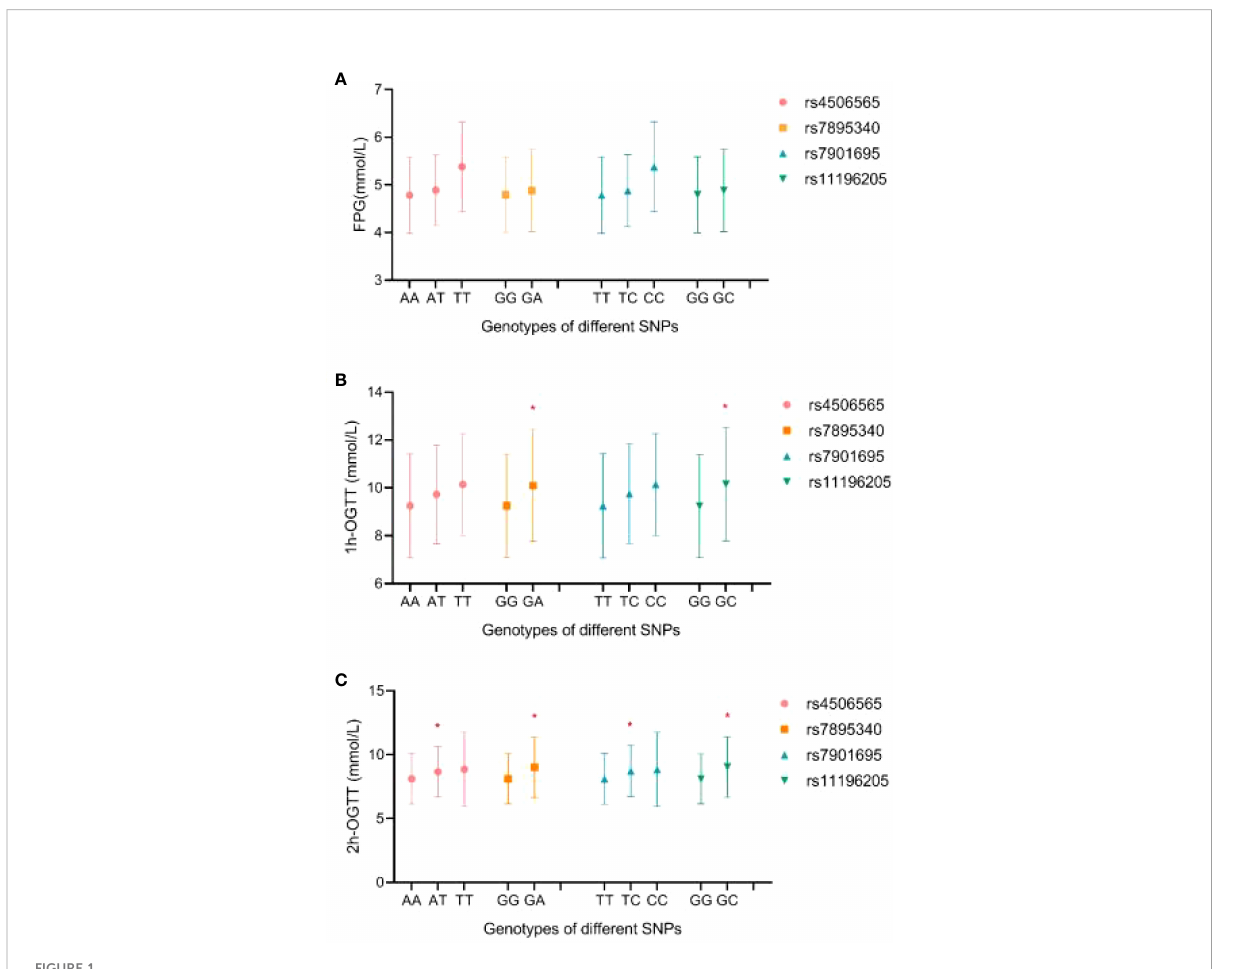
FIGURE 1 The distribution of FPG (A) , OGTT-1h (B) , and OGTT-2h (C) levels by different genotypes. FPG, fast plasma glucose; OGTT-1h, 1-h result of oral glucose tolerance test; OGTT-2h, 2-h result of oral glucose tolerance test. *Compared with homozygous of major allele, p <